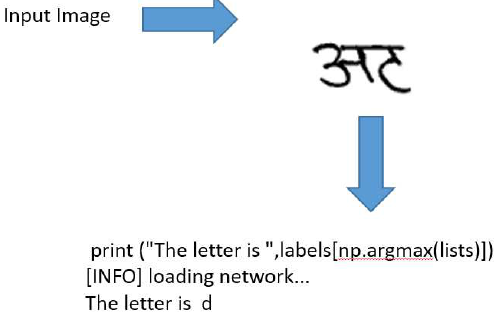
Fig. 10. Output of the Trained Model Fig. 7. Block Diagram Fig. 10. represents the output of the model after